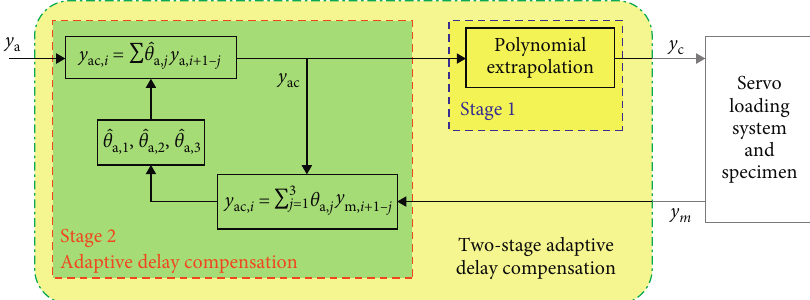
Figure 1: Schematic of the two-stage adaptive delay compensation method.